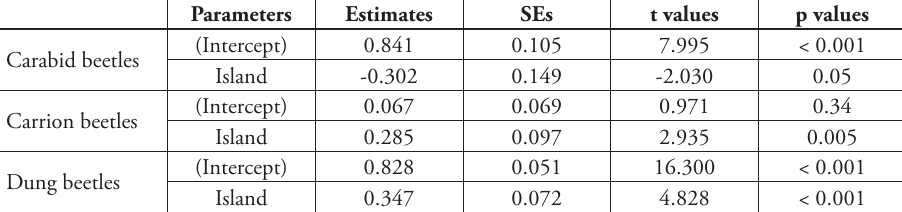
Table 3. Estimates of parameter differences between sites (reference = lakeshore site, i.e., coefficients of lakeshore site are zero), standard errors (SEs), t values, and p values in generalized linear models of each of taxonomic group and body size group Shannon-Wiener diversity index. Bold letters represent p <